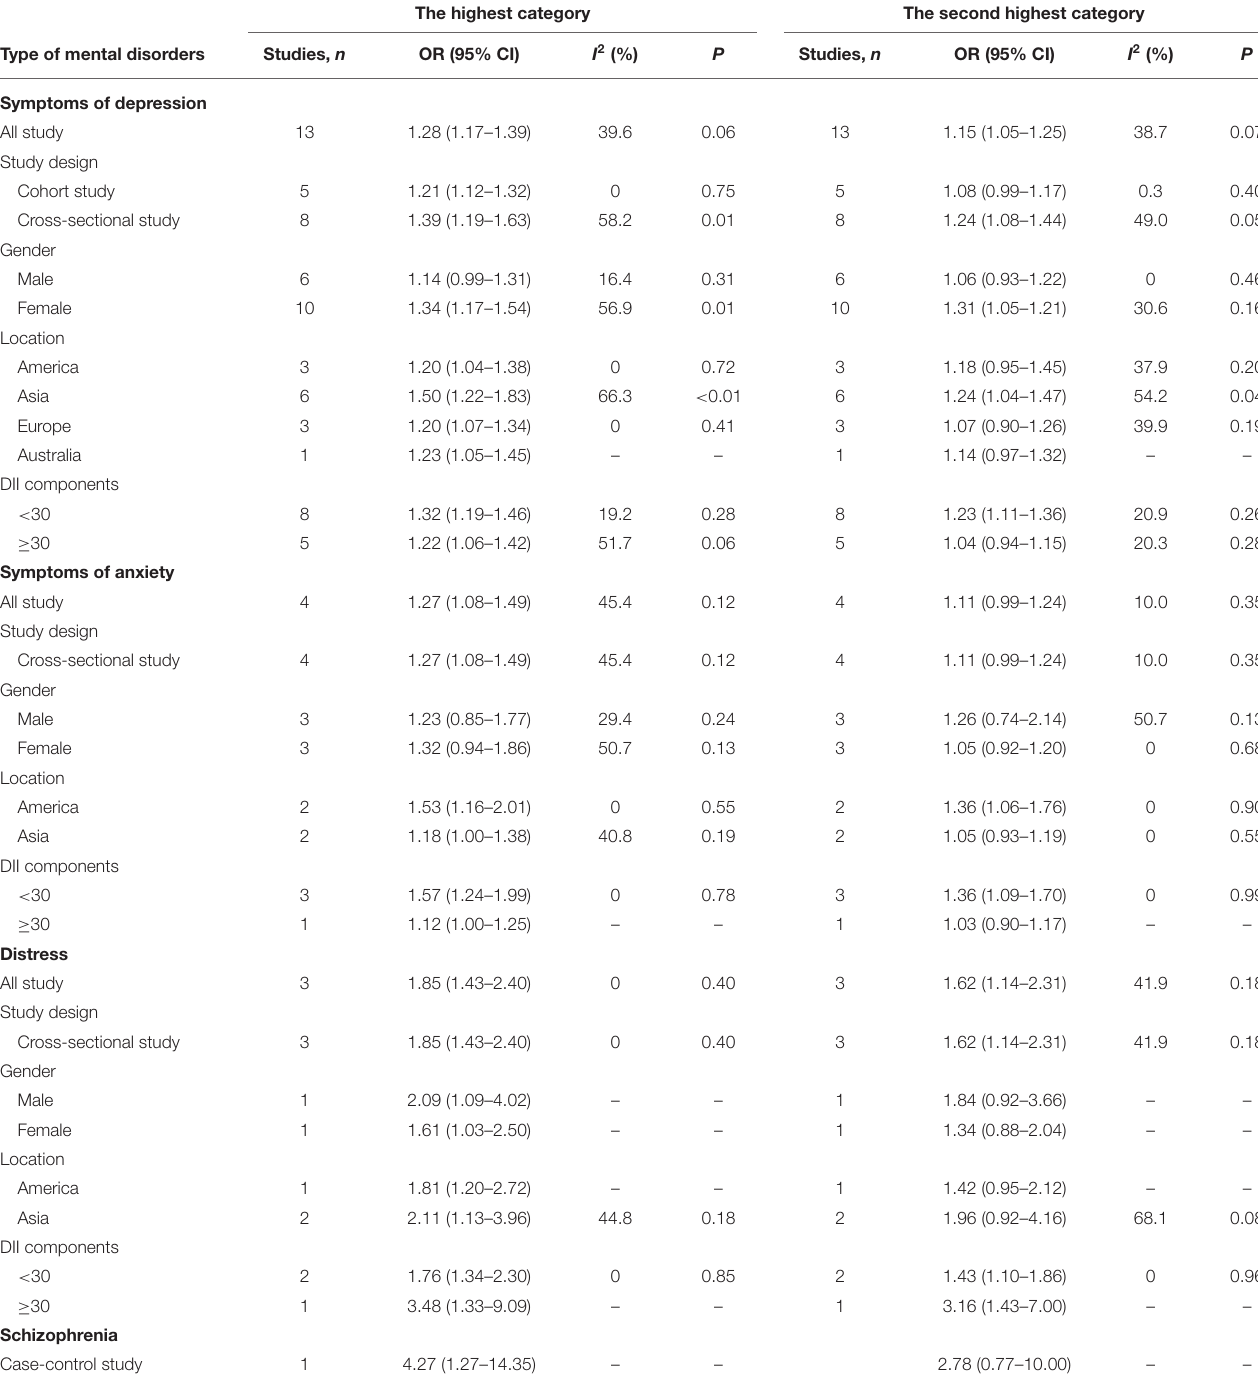
FFQ: Food frequency questionnaire, CES-D: Centre for Epidemiologic Studies Depression Scale, HRQOL: Health-Related Quality of Life, GHQ: General Health Questionnaire, HADS: Hospital Anxiety and Depression Scale, PHQ-9: Patient Health Questionnaire-9, DASS: Depression Anxiety and Stress Scale, ICD-10: International Statistical Classification of Diseases-10, BDI-II: Beck Depression Inventory II, BAI: Beck Anxiety Inventory. DII, Dietary Inflammatory Index.